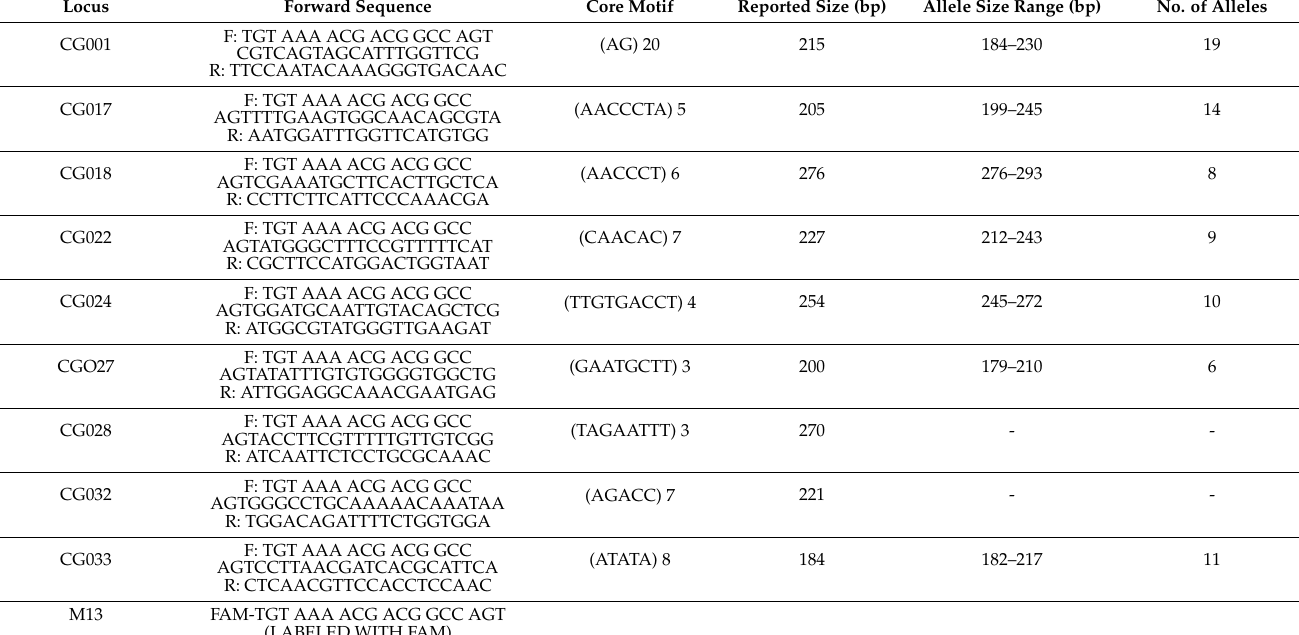
Table 3. Microsatellite primer sequence and core motif used in the analysis, allele size range and number of alleles for local and exotic spider plant